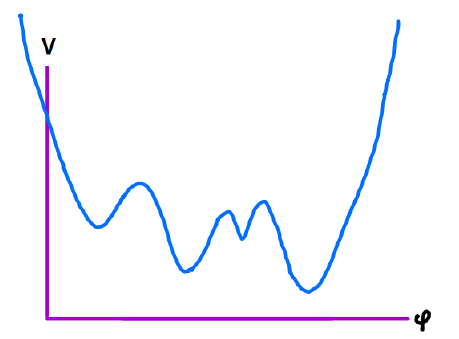
Figure 1. A schematic landscape for eternally stable de Sitter space. The universe spends most of its time in the lowest minimum with rare fluctuations to higher